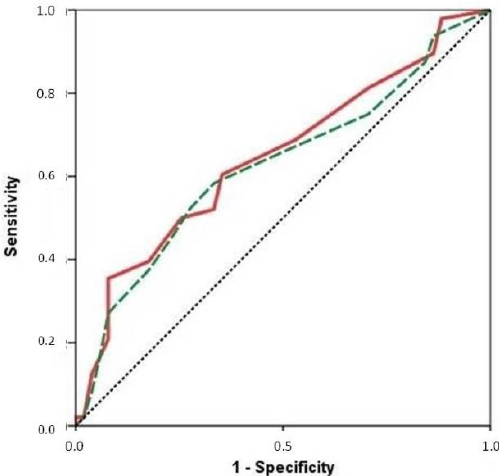
Figure 1. ROC curve showing the diagnostic performance of the SPPB (dashed green line) and the modified-SPPB (continuous red line) scale to detect frailty defined as FRAIL score > 3 in the older group of patients.